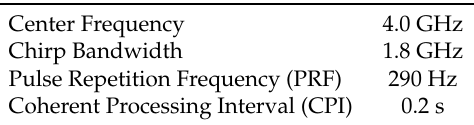
Table 1. Radar configuration parameters.